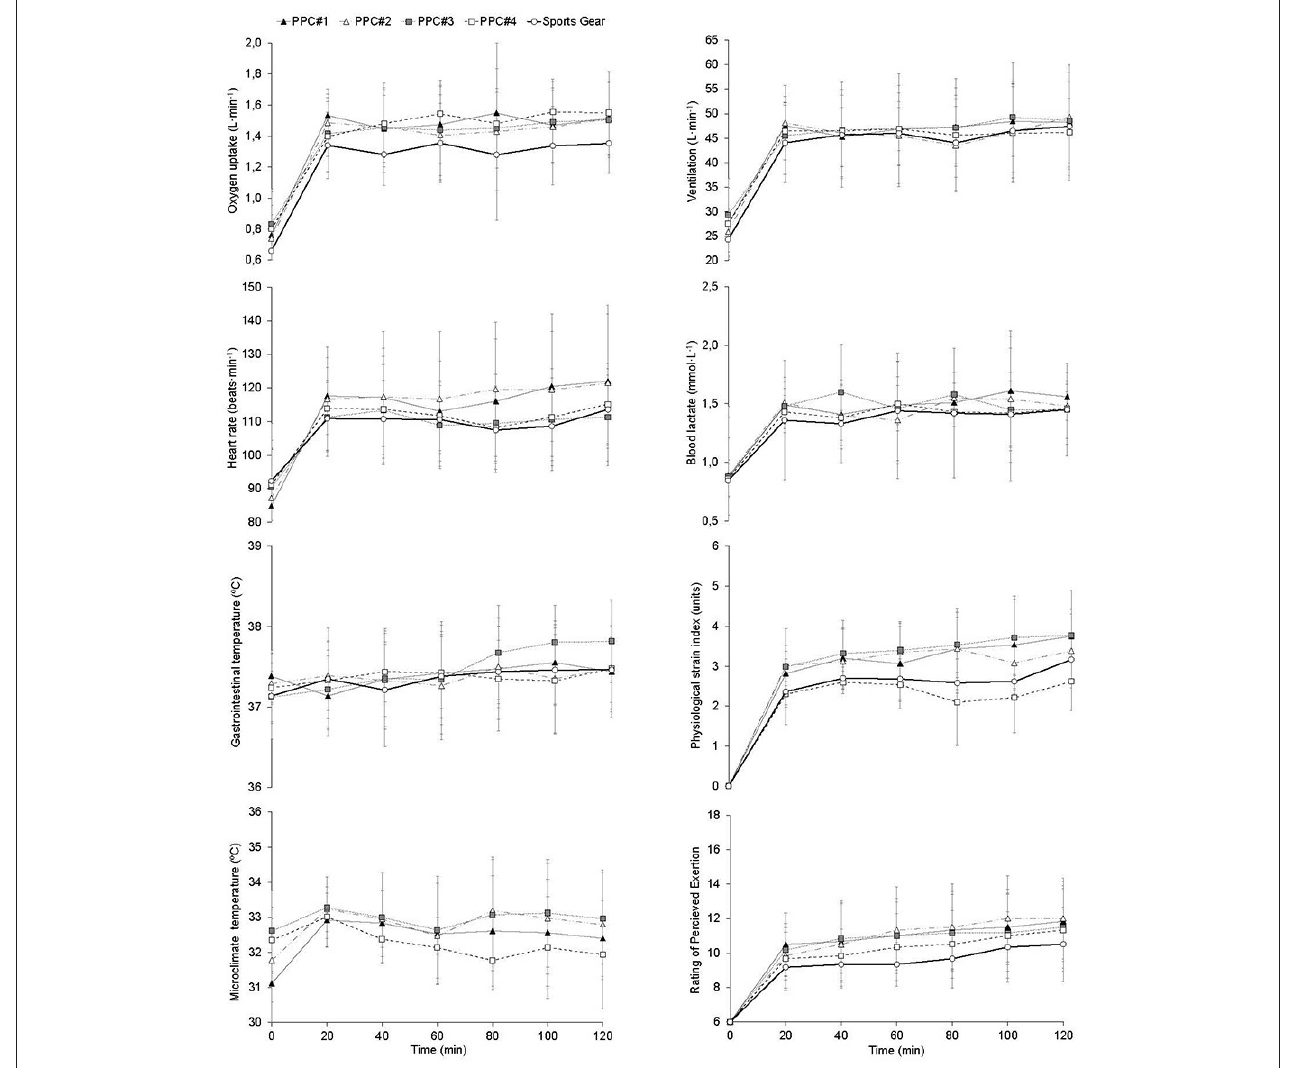
FIGURE 1 | Comparative responses of oxygen uptake, ventilation, heart rate, blood lactate concentration, gastrointestinal temperature, physiological strain index, temperature of the microclimate underneath the personal protective clothing (PPC), and rating of perceived exertion during the different trials.